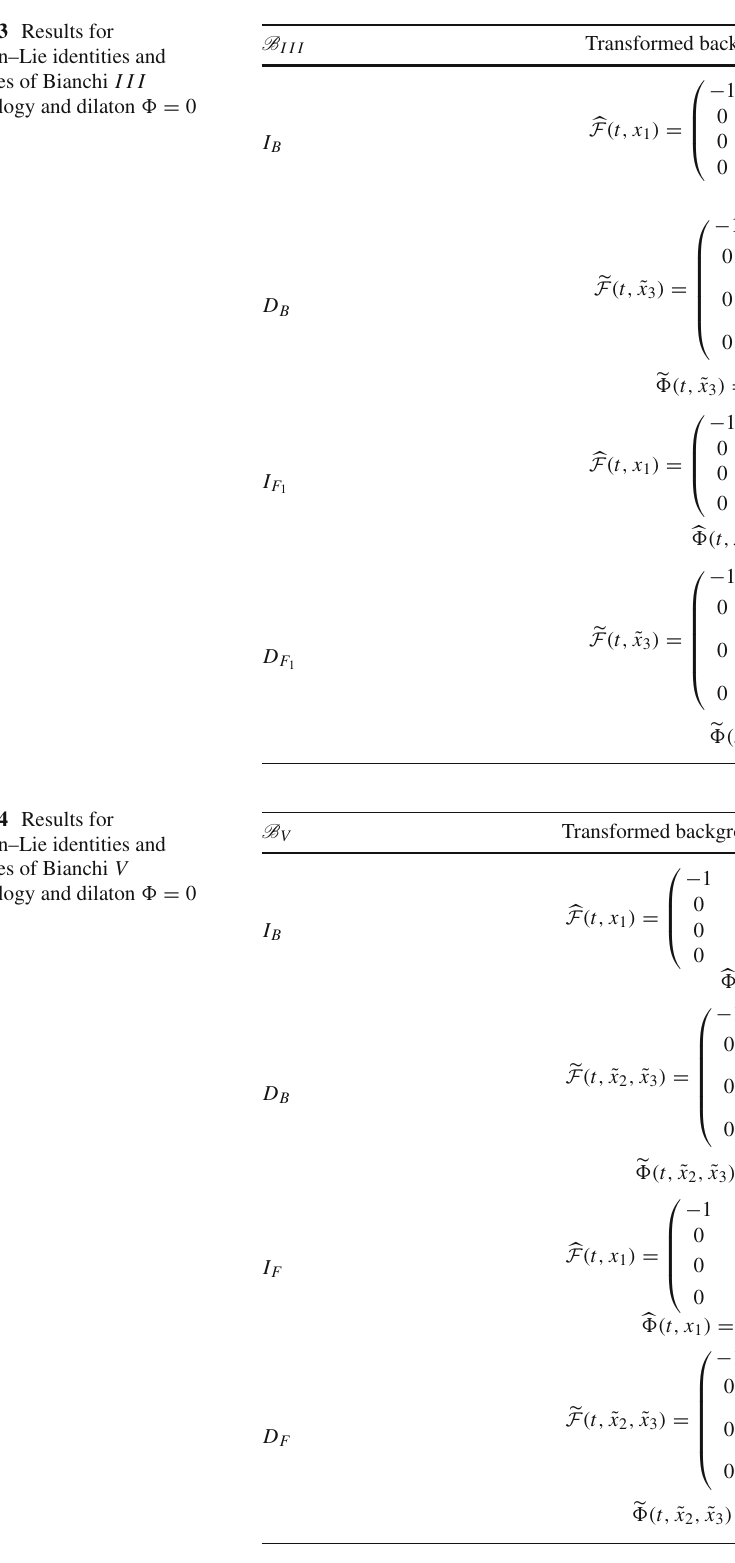
B III Transformed backgrounds, dilatons and vectors